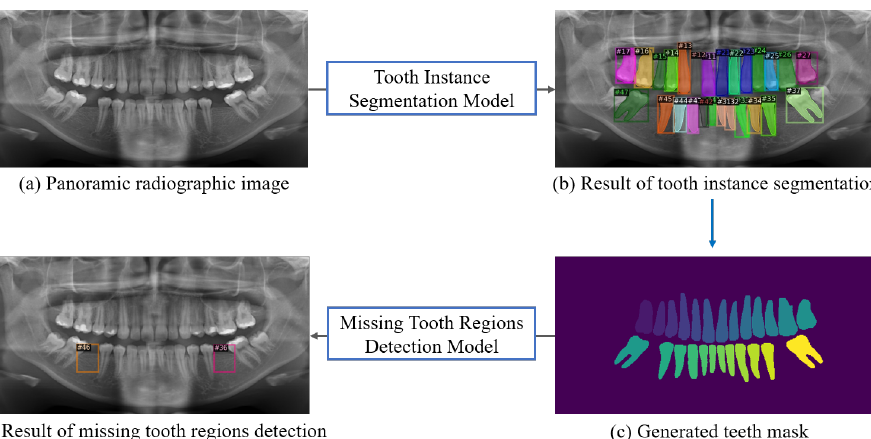
Figure 4. Entire process for missing tooth region detection. Tooth instance segmentation model segments 28 teeth, excluding the third molars, in the ( a ) panoramic radiographic image. ( b )